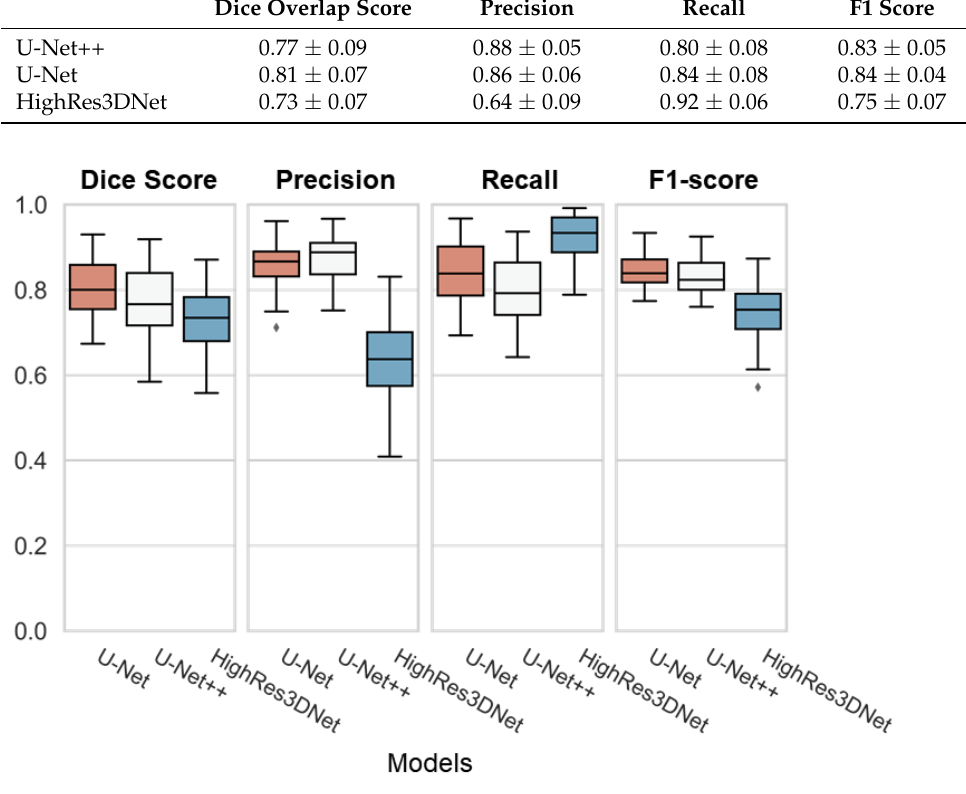
Figure 6. Boxplot of all three models (U-Net, U-Net++, and HighRes3DNet) with individual evalua- tions (Dice Score, Precision, Recall, and F1-score). Each box represents the interquartile range (IQR) with its median line in the box. The whiskers represent the range of extended IQR by 1.5 times, and the dot outside of the whiskers represents the